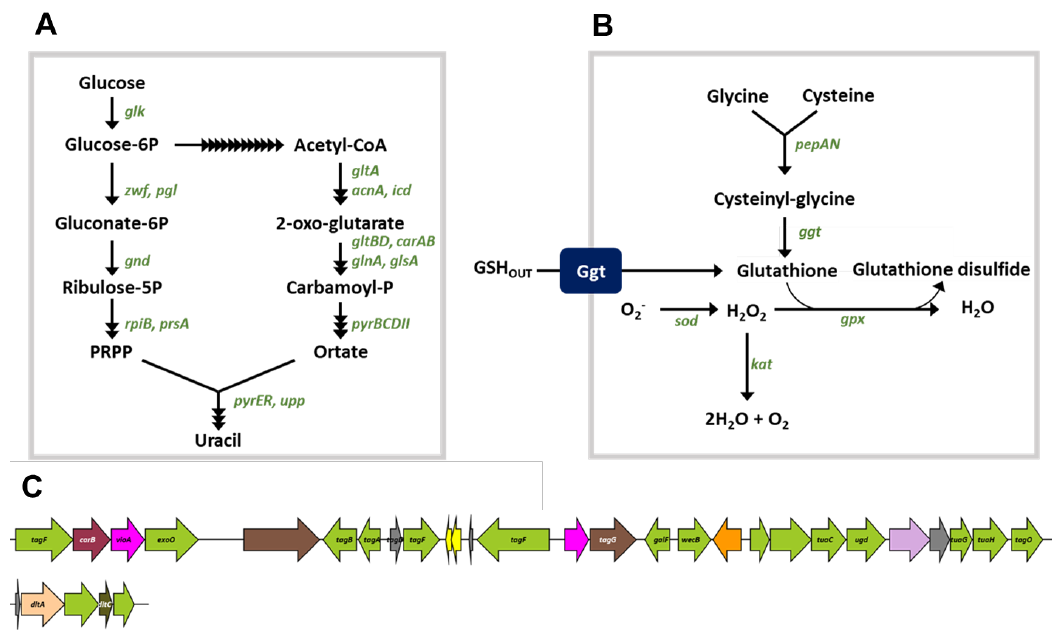
Figure 4. Synthesis pathways of uracil ( A ) and glutathione ( B ), and operon for lipoteichoic acid synthesis ( C ) in B. siamensis strain B28. Potential enzyme-encoding genes are displayed in green letters. The black arrows indicate potential enzymatic reactions in the B28 genome.